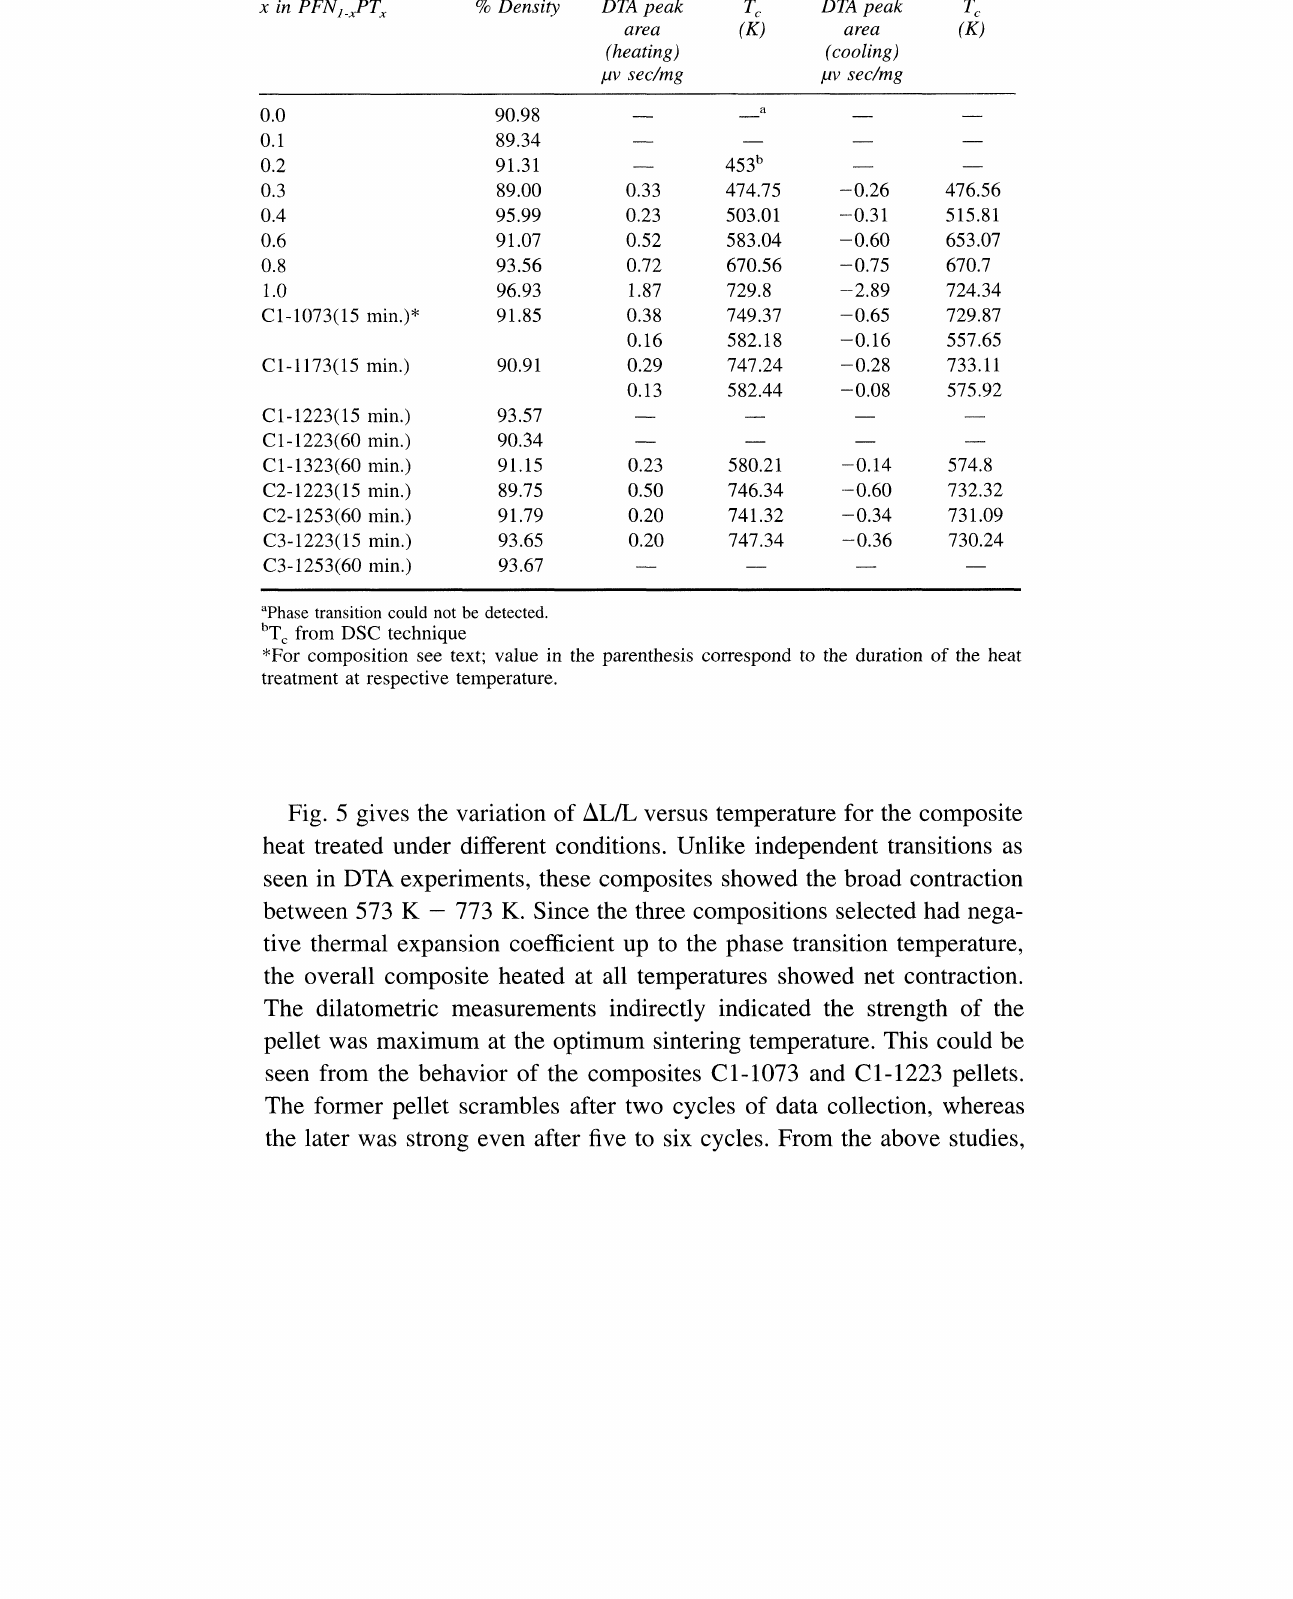
Sintered pellet densities and DTA results for PFNI_PTx solid solutions and